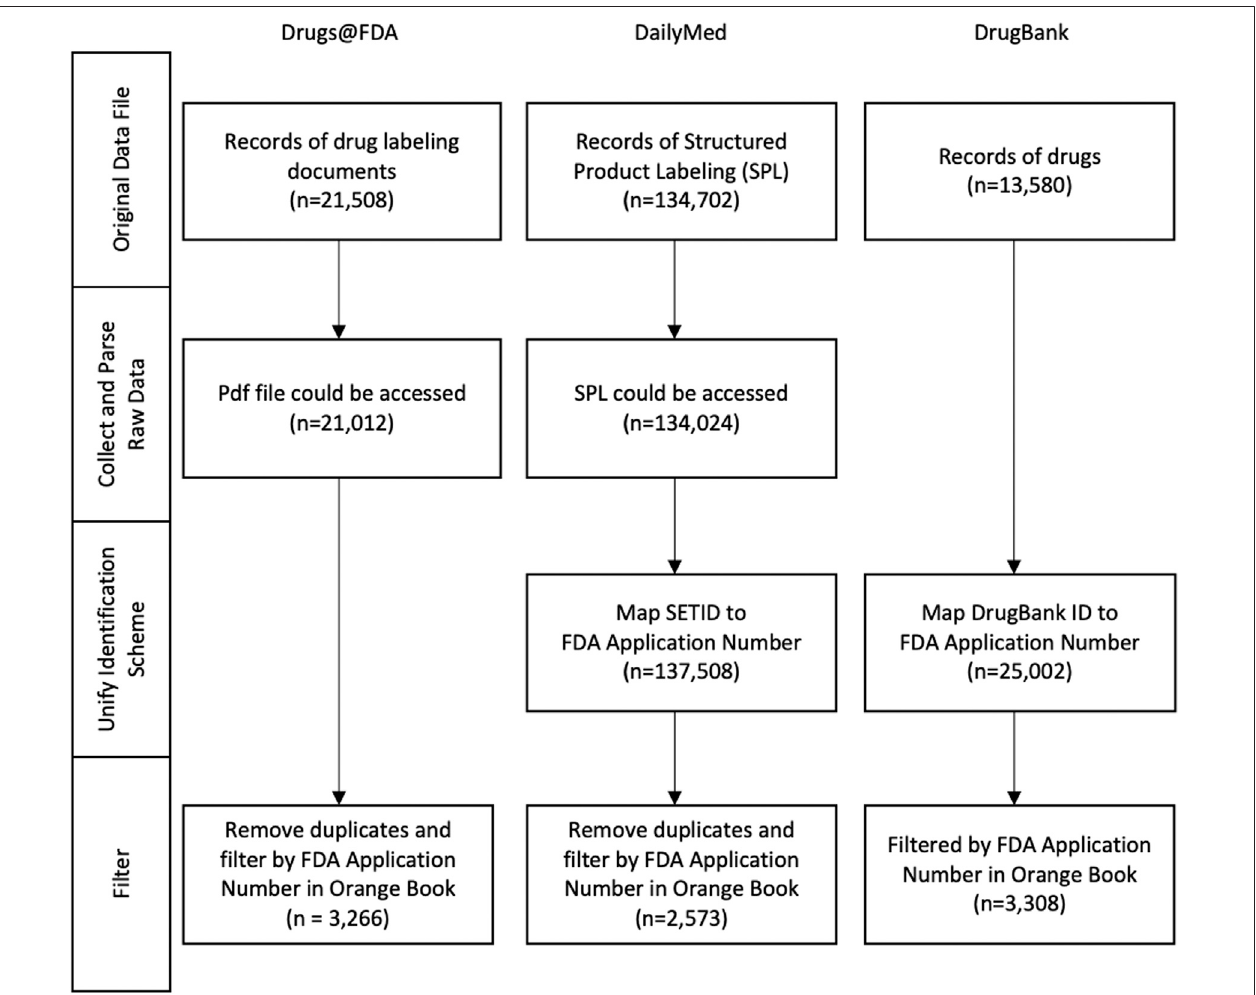
FIGURE 1 | The birds ’ eye view of the work fl ow used for information extraction from various data sources, as shown at the top, which includes Drugs@FDA, DailyMed and DrugBank. On the left depicts the main steps of information extraction. Note that the Orange Book is used as a point of reference for the FDA NDA (New Drug Application) application number with which the data extracted from multiple sources are integrated at the step of Filter (Downloaded Version: Oct. 2020).